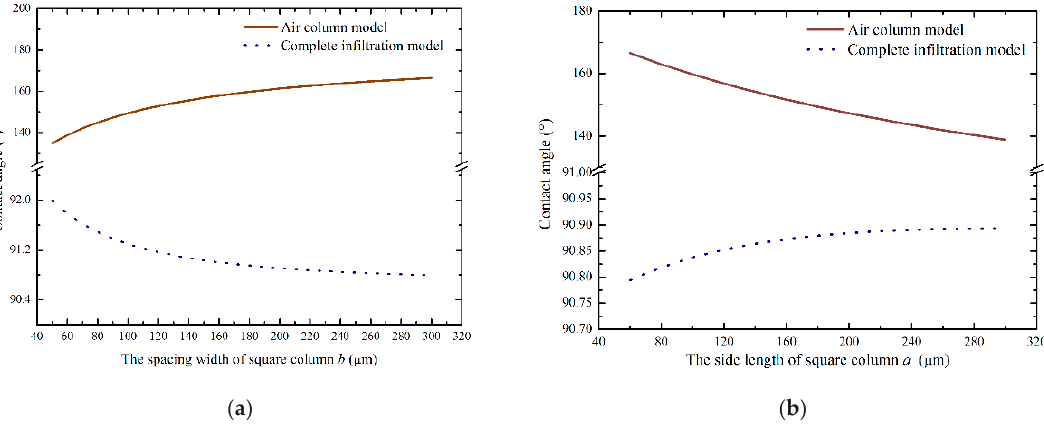
Figure 2. Correlation between the contact angle and structural parameters: ( a ) the spacing width of square column and ( b ) the side length of the square column.